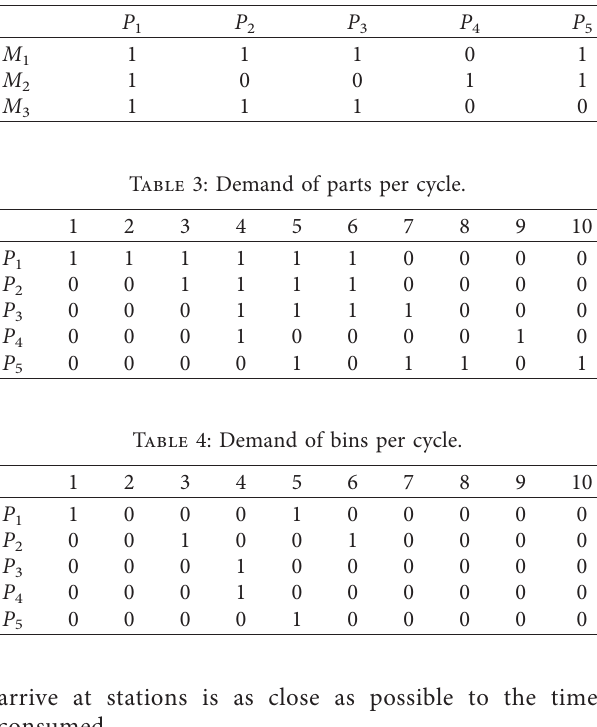
Table 2: Bill of material (BOM).